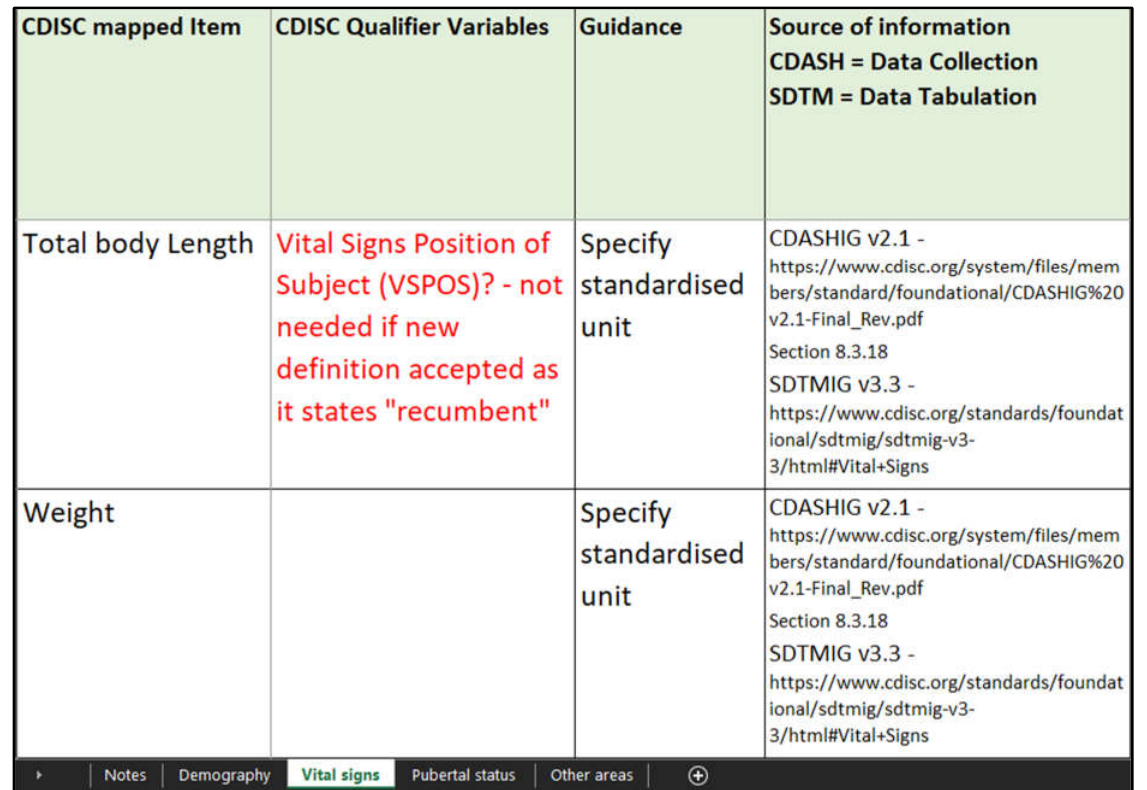
Figure 2. Microsoft Excel worksheet showing the c4c data dictionary item for BodyMeasurement.